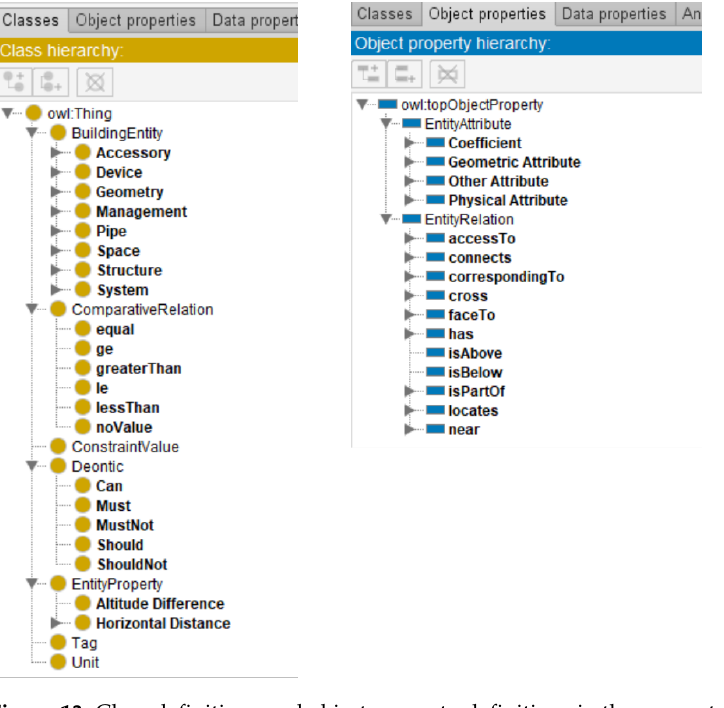
Figure 13. Class definitions and object property definitions in the concept ontology.